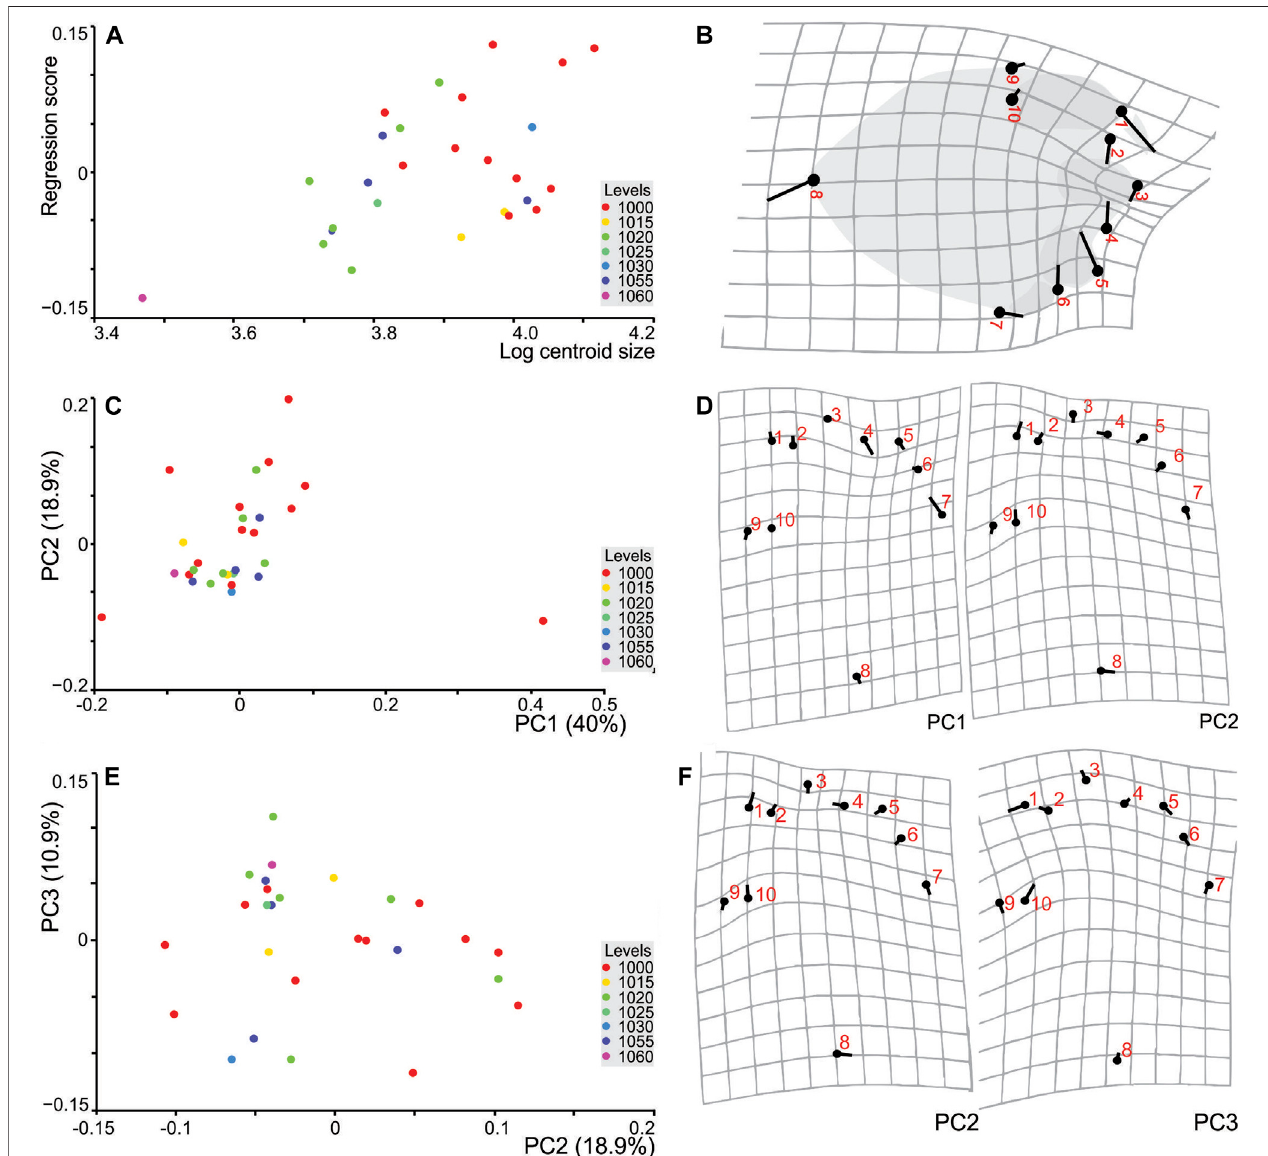
FIGURE 8 | TCH geometric morphometric plots. (A) Multivariate regression of the TCH pes shape onto size (as logarithm of centroid size) classi fi ed by Level. (B) Deformation grid re fl ecting shape changes (blue dots represent landmarks labelled 1 – 10). (C) Principal components plot of PC1 vs. PC2 of TCH pes tracks pooled by Level(stratigraphiclevel). (D) Shapechangesarevisualisedbythetransformation grids. (E) PC2vsPC3ofpestracksfromTCHsitepooledbyLevel. (F) Shapechanges are visualised bythe transformation grids. The black numbered circles (centroids) indicate the average landmark coordinates ofthe mean shape ofthe sample; the sticks indicate the changes in their relative positions and are emphasized by the green wireframe. Numbers reference landmarks.